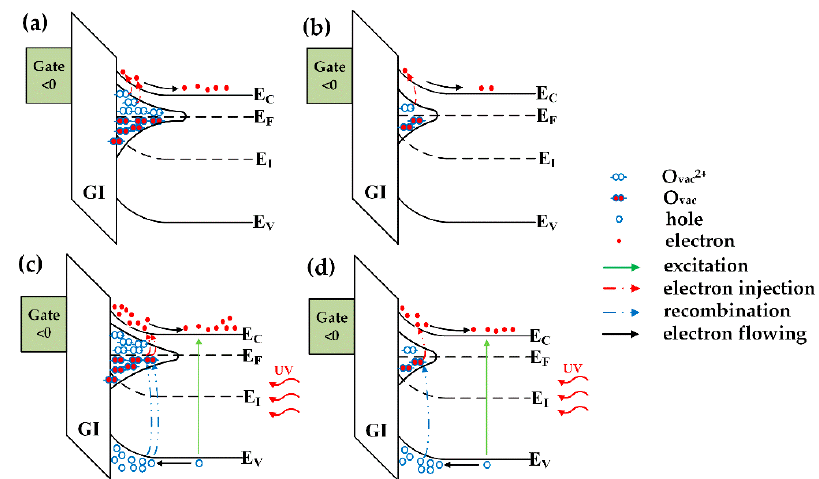
Figure 6. Energy band diagram of: ( a ) as-deposited a-IGMO photo-TFT in dark; ( b ) annealed a-IGMO photo-TFT in dark; ( c ) as-deposited a-IGMO photo-TFT under 350-nm UV illumination, and ( d ) annealed a-IGMO photo-TFT under 350-nm UV illumination. All the devices are in off states.